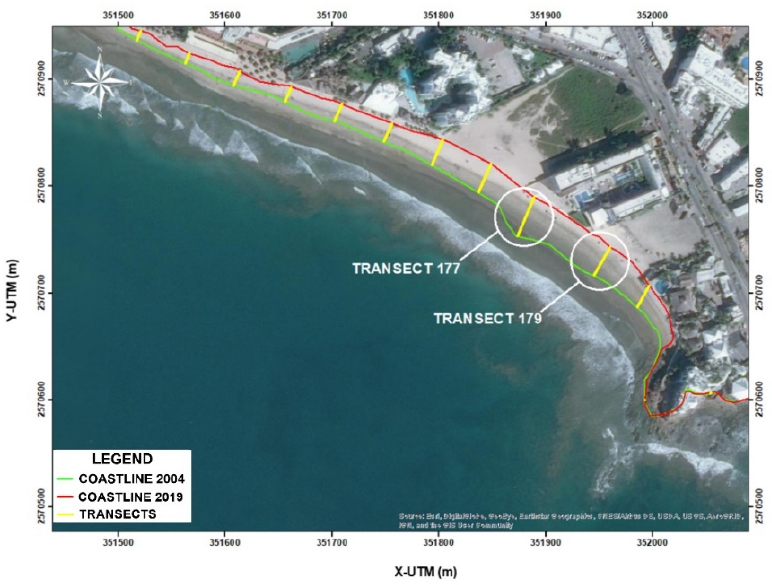
Figure 9. Locations of the transects with greatest retreats on the beach in the Golden Zone.